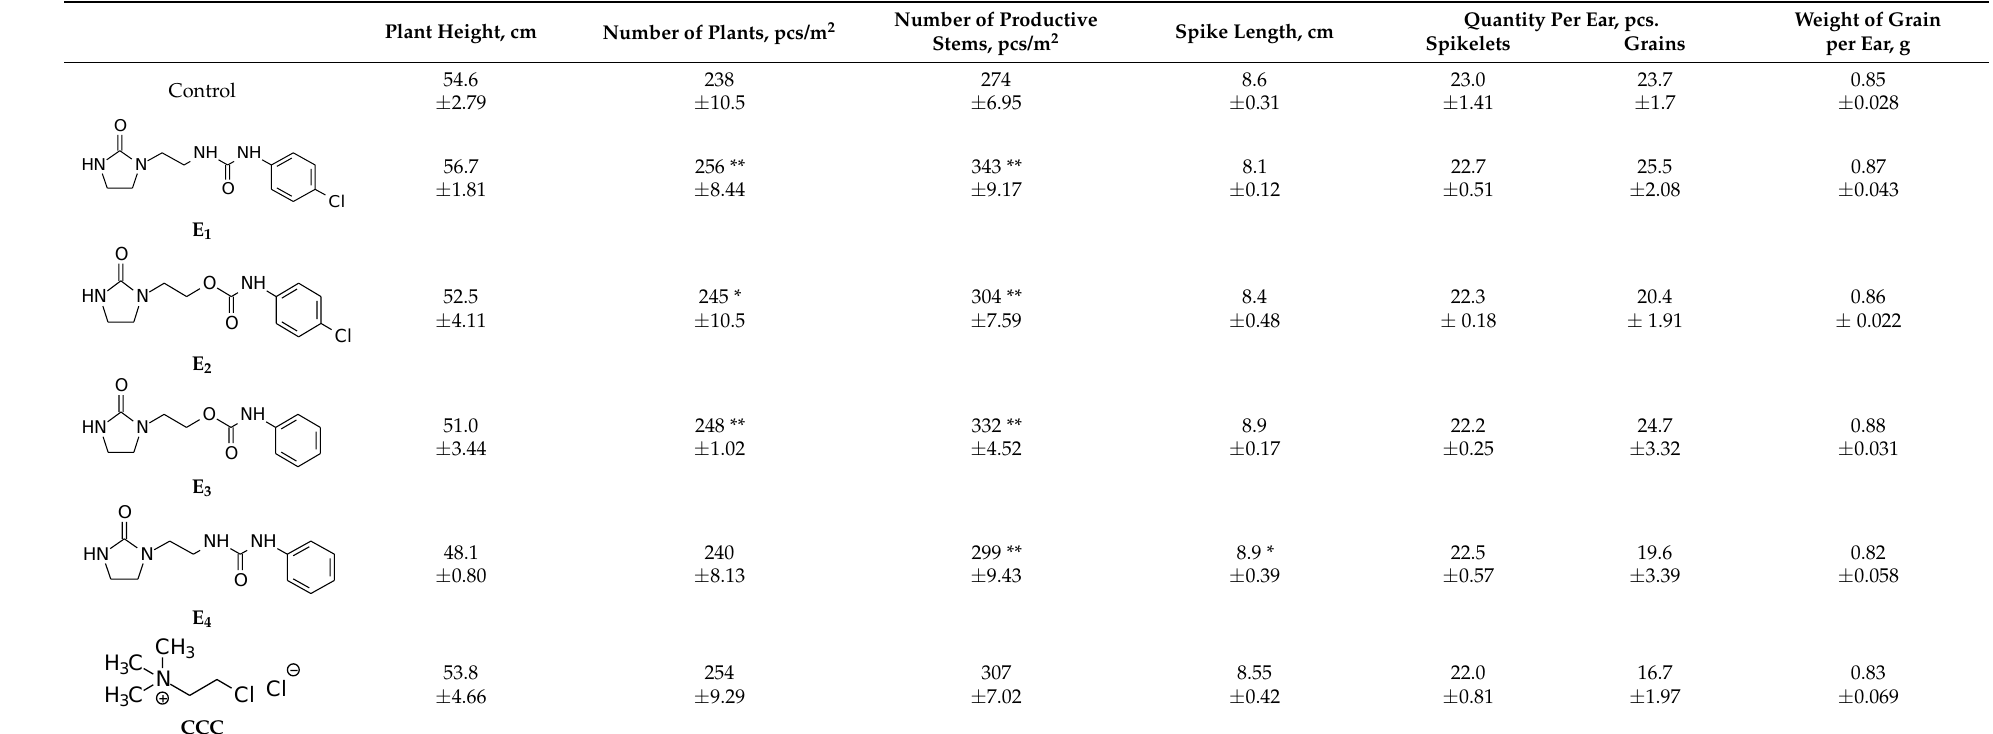
Weight of Grain per Ear, g